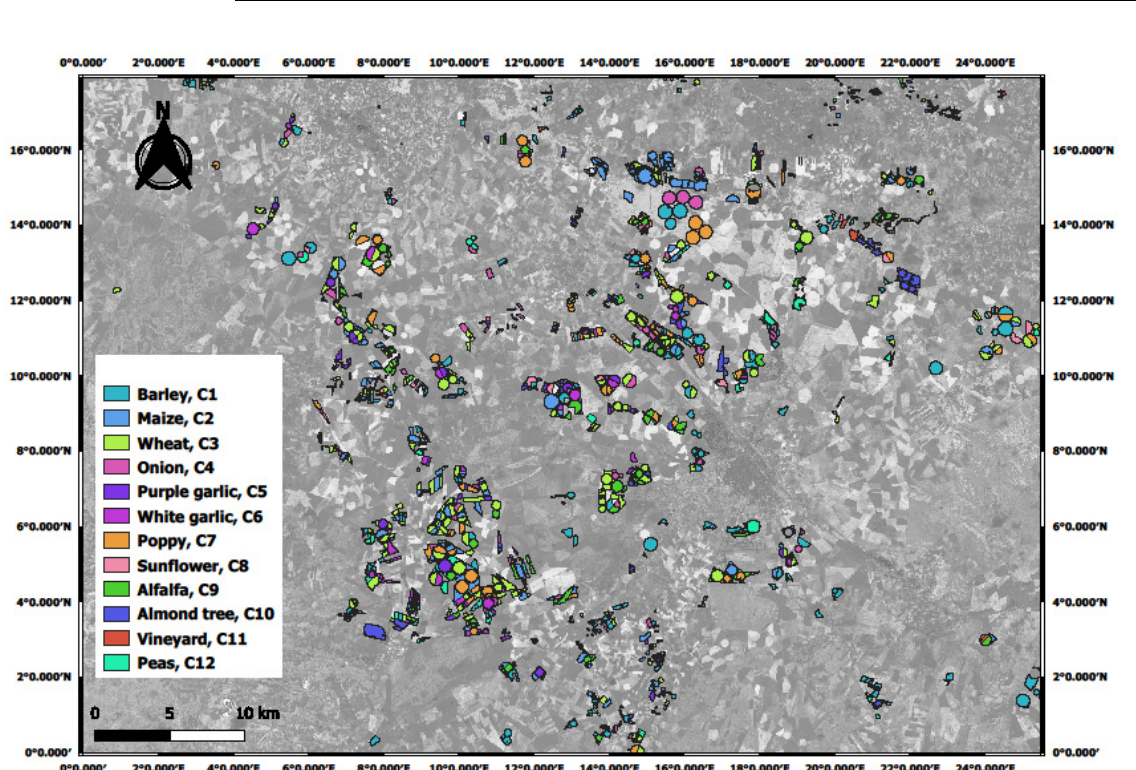
Figure 10. Visualization of the classification results with the M8 classifier within the seventh scenario.